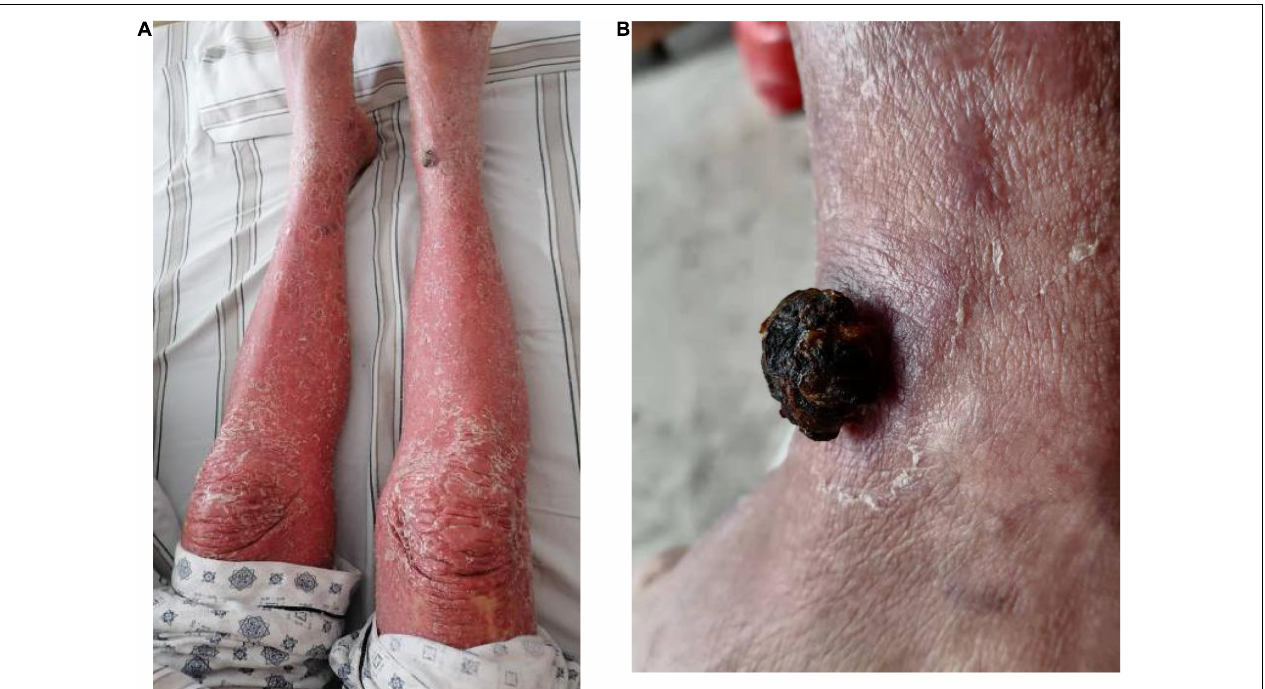
FIGURE 1 | Clinical pictures of the patient. (A) One 2.0 × 2.5 cm purple papule on the right limbs after DRESS syndrome improved. (B) 2.5 × 2.5 cm purple papule on the right limbs after DRESS was cured.